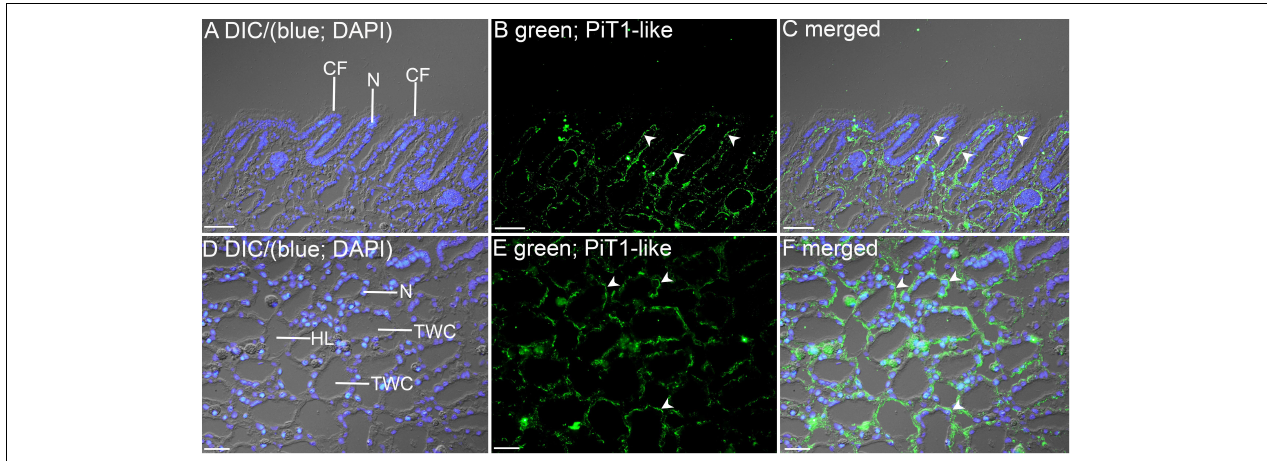
FIGURE 5 | Immunofluorescence localization of a homolog of sodium-dependent phosphate transporter protein 1 (PiT1-like) in the filament (A–C) or the tertiary water channels (D–F) in the ctenidium of Tridacna squamosa exposed to 12 h of light. (A,D) Differential interference contrast (DIC) image is overlaid with DAPI nucleus (N) stain in blue to demonstrate the histological structure of ctenidium filament (CF) and tertiary water channel (TWC). (B,E) PiT1-like-immunofluorescence is displayed in green. (C,F) The green and blue channels are overlaid with DIC. Arrowheads in (B,C) show extensive basolateral staining of PiT1-like on the epithelium (EP) of CFs. (E,F) indicates the presence of PiT1-like on the basolateral membrane of the tertiary water channels. HL, hemolymph. Scale bar: 20 µ m.